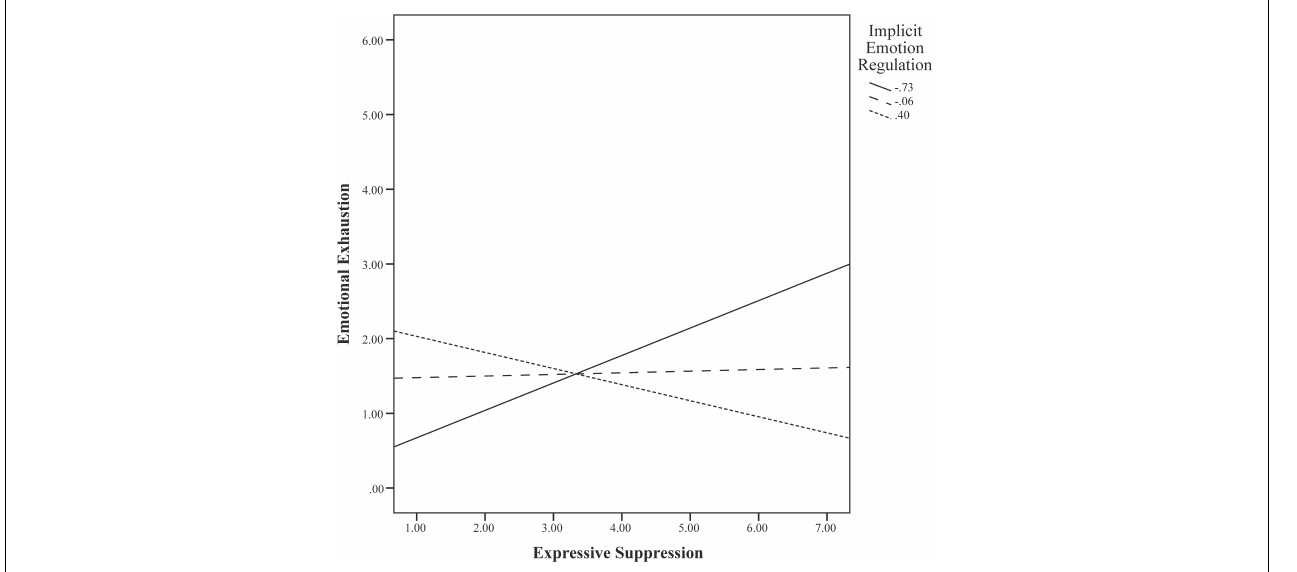
FIGURE 1 | Visualization of the moderating effect of implicit attitudes toward emotion regulation on the relationship between expressive suppression and emotional exhaustion within the subsample (step 2).